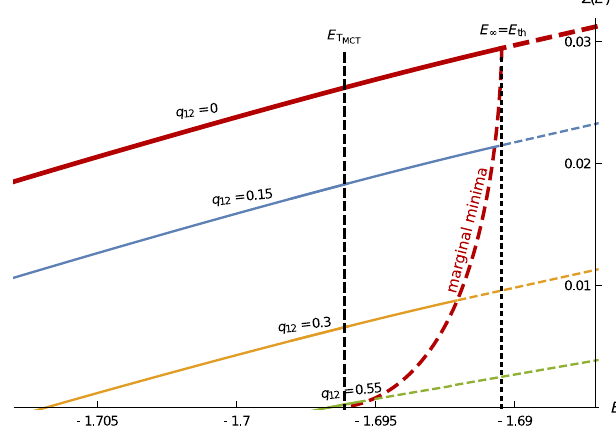
FIG. 18. Constrained complexity at an overlap q 12 from a reference configuration sampled at temperature T ¼ T . Ver- MCT tical lines mark energy values E ∞ (dotted line on the right) and E (dashed line on the left), corresponding to extrapolated T MCT asymptotic energies reached by the dynamics starting, respec- tively, from T ¼ ∞ and T ¼ T . From a random configuration MCT with T ¼ ∞ , the dynamics goes to the energy level E , where the th dominant stationary points are marginal minima, while starting near T , the dynamics goes below E . If q 12 > 0 , the energy MCT th where marginal minima dominate decreases, and we represent it with a bold dashed red